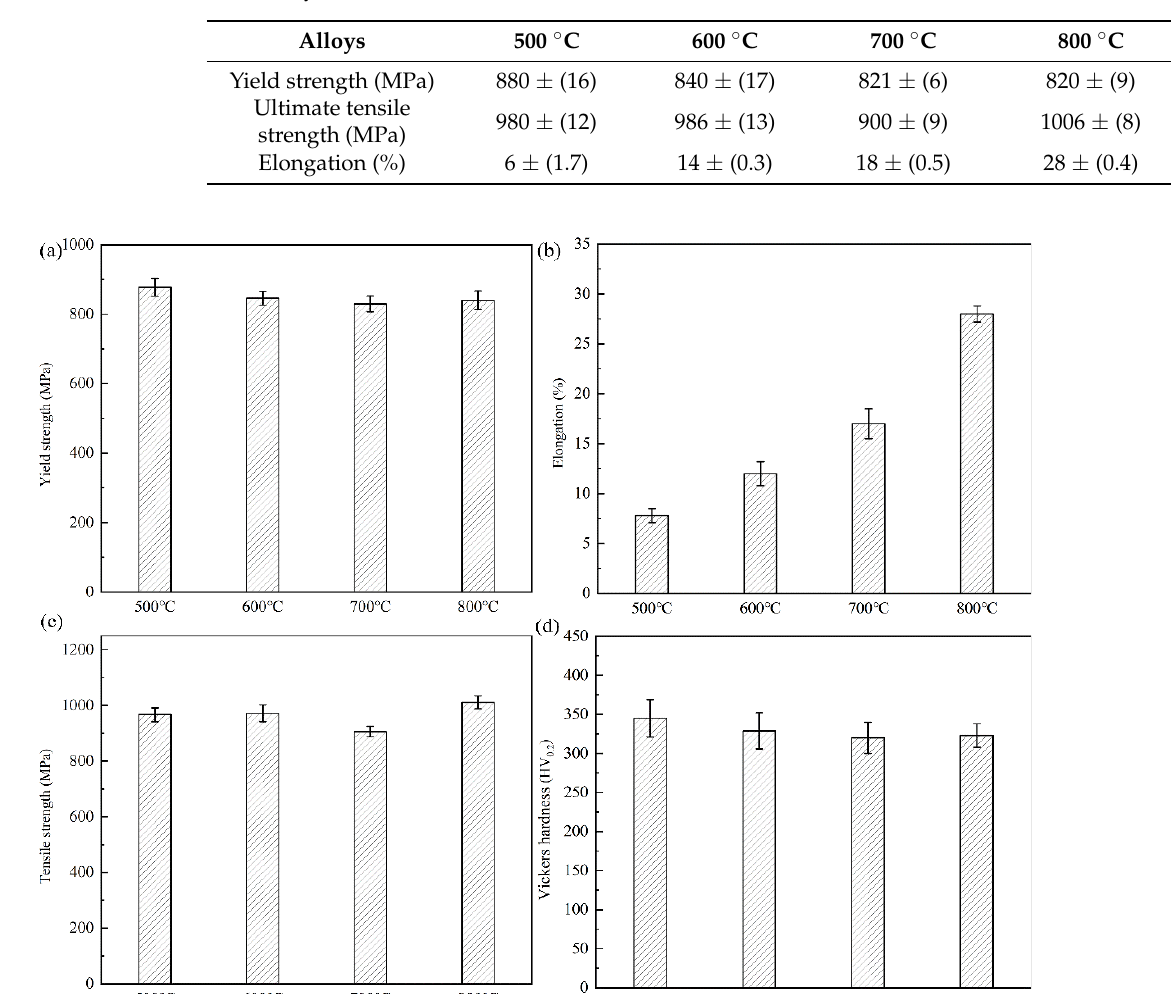
Figure 5. Tensile mechanical properties and Vickers hardness of Ti-20Zr-15Mo alloy after annealing: ( a ) yield strength; ( b ) elongation after fracture; ( c ) tensile strength; ( d ) Vickers hardness.